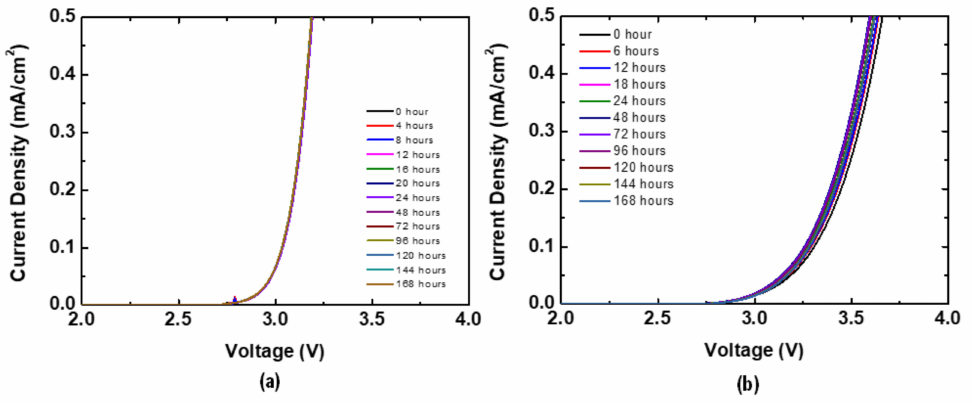
Figure 2. J-V curves under constant current stresses at ( a ) 2.5 × J D and ( b ) 15 × J D .